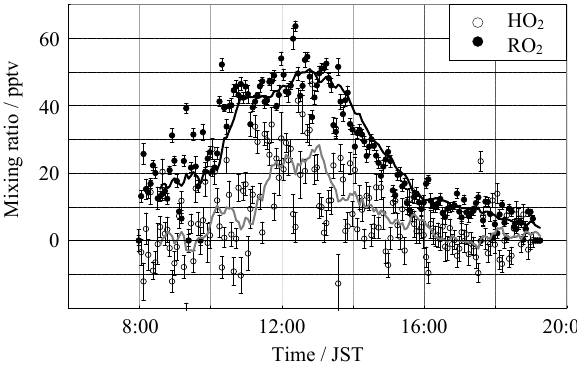
Fig. 6. In situ measurements of HO 2 and RO 2 radical concentra- tions with 1 σ precision error bars. Each solid line indicates the 10 points moving average data. The measurements were obtained on 23 July 2010 in Hachioji,